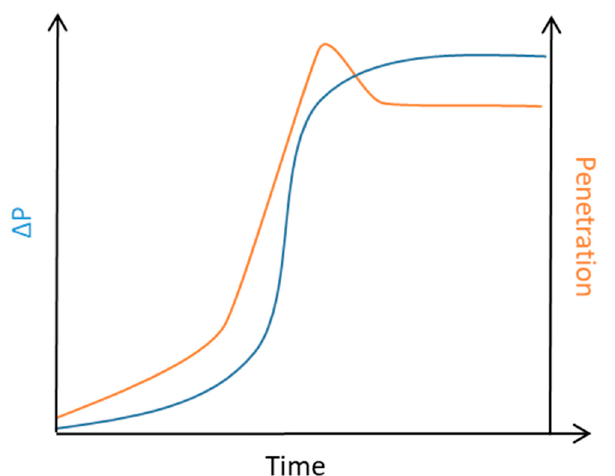
Figure 1. Pressure drop evolution and penetration (for particles < 10 µ m) as a function of time.